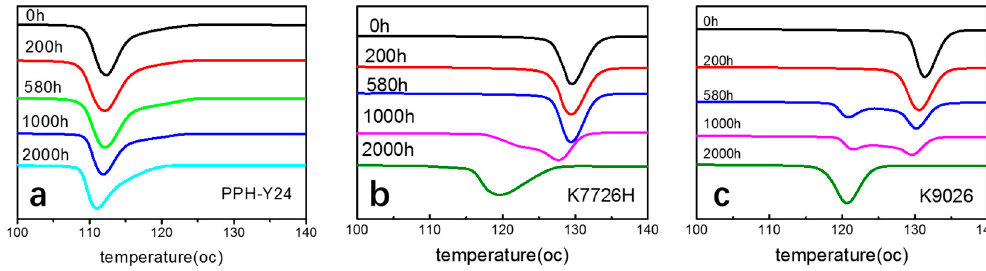
Figure 8. Differential scanning calorimetry (DSC) thermograms for the non-isothermal crystallization of PP resins after photoaging at different photoaging time. (( a ), PPH-Y24; ( b ), K7726H; ( c ), K9026; heat flow endo up).